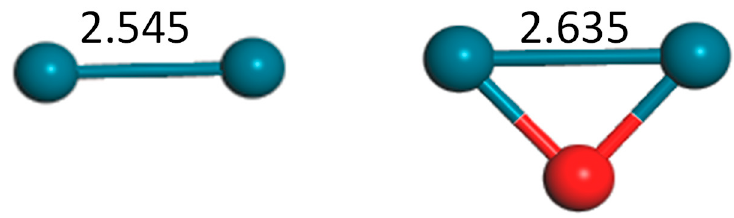
Figure 1. Structures of dimer Pd 2 and trimer Pd 2 O (bond unit, Å; turquoise: Pd, red: O).